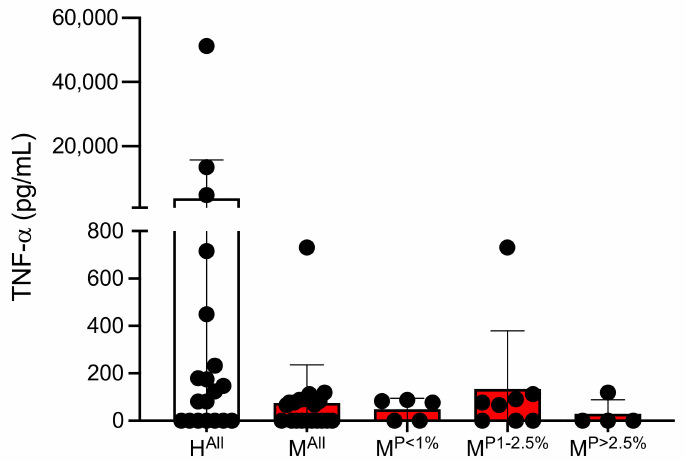
Figure 2. Amount of TNF- α in plasmas of malaria patients and healthy individuals (Supplementary Table S4). Abbreviations: Healthy controls (H All ); malaria patients (M All ); malaria patients with